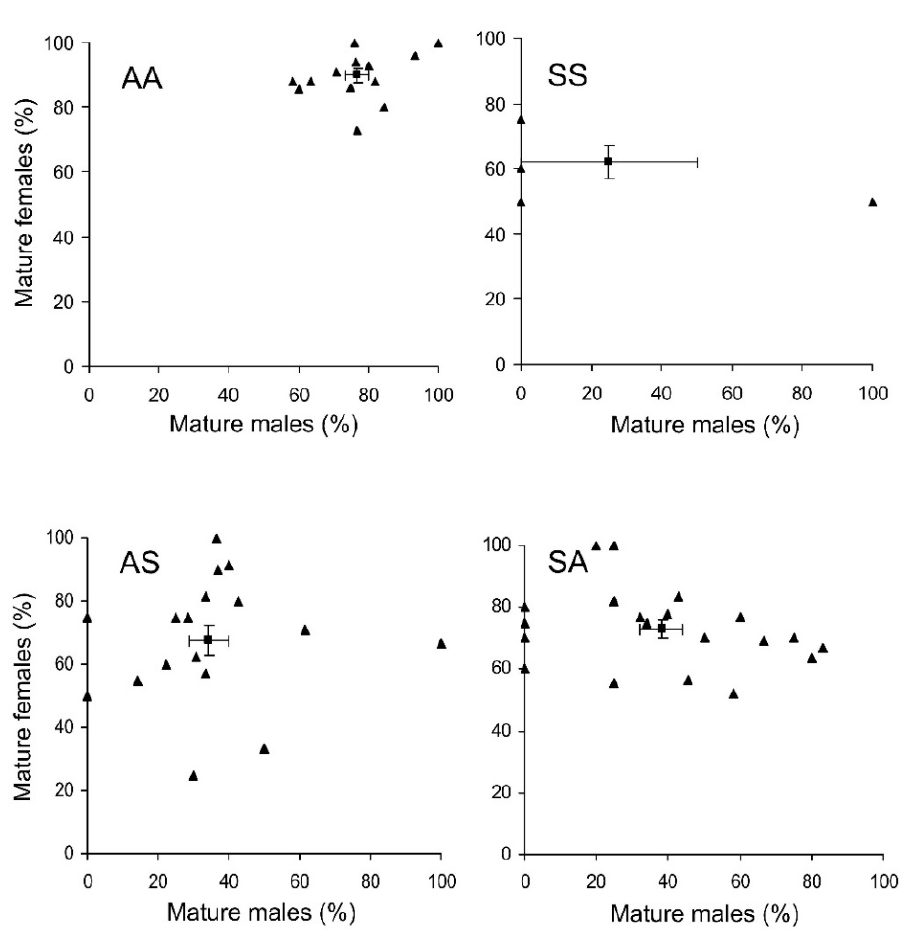
Figure 3. The proportion of mature individuals among non-diapausing progeny of different parental pairs of Halyomorpha halys cross types. The cross types are indicated by the initials of population origin of female and male: A—Andong, S—Sochi. Each symbol (triangle) corresponds to one parental pair; the percentages of mature male (X-axis) and female (Y-axis) progeny are shown, mean and SEM are also presented. Some symbols are slightly shifted to avoid overlap. Progeny of all pairs of all cross types developed under the same conditions (25 °C, L:D 15:9 h).